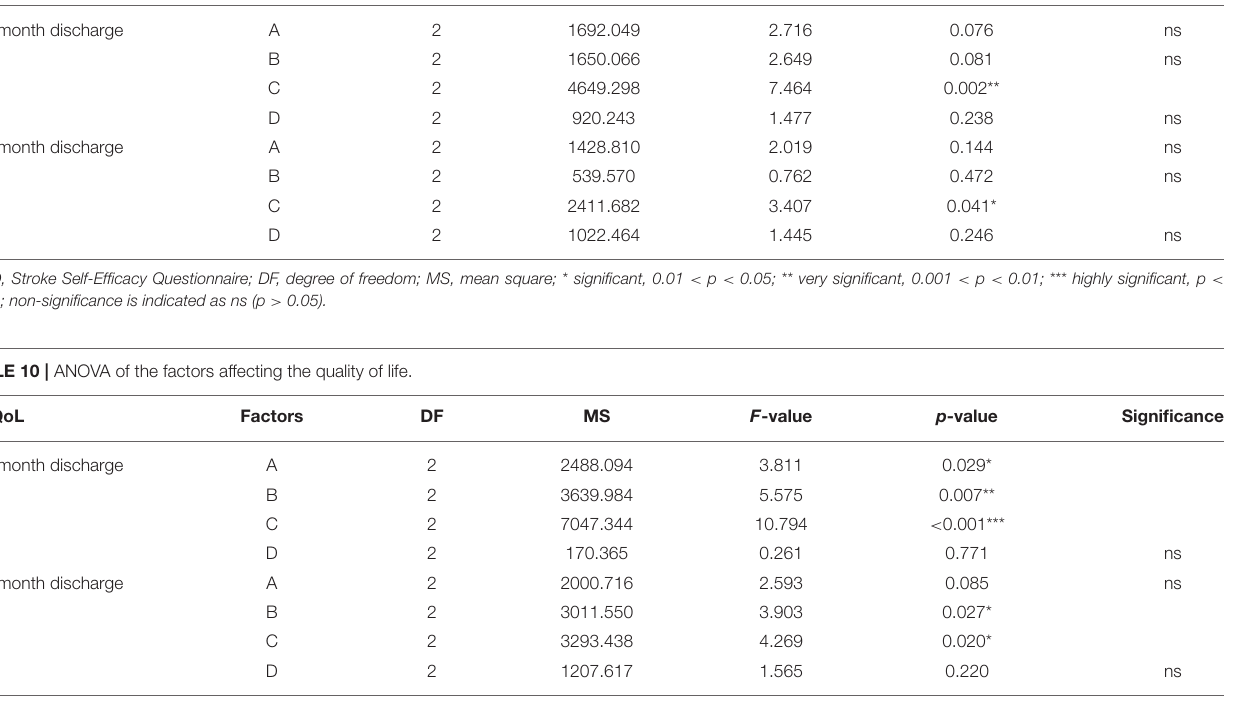
TABLE 9 | ANOVA of the factors affecting self-efficacy. SSEQ Factors